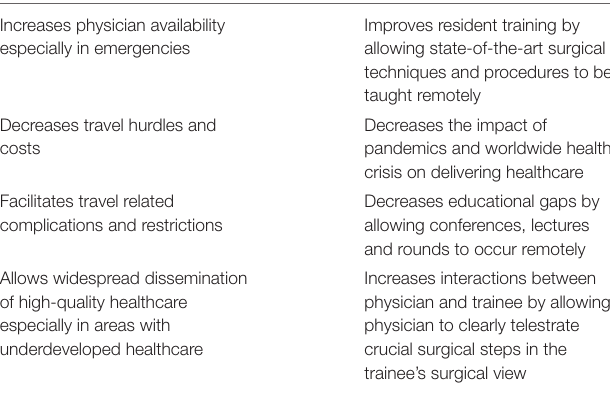
TABLE 1 | Benefits of telementoring and